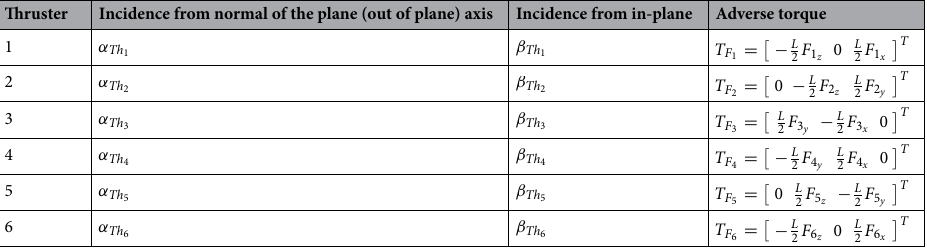
Table 1. Thrusters’ adverse (disturbing)